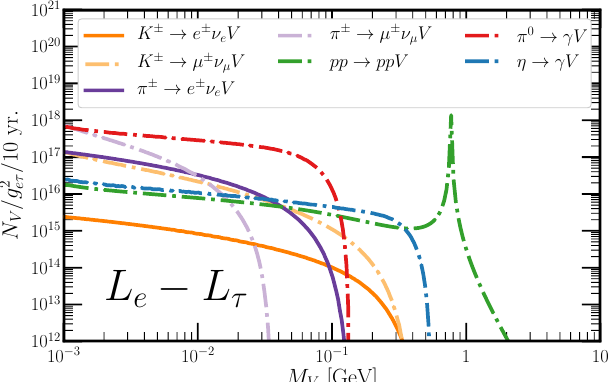
Figure 10 . The number of L e L (cid:28) gauge bosons V traveling towards the DUNE MPD as a (cid:0) function of mass M V assuming ten years of data collection, and equal run time in neutrino and antineutrino modes. Solid lines display expected number due to charged meson decays | purple ( (cid:25) (cid:6) ) and orange ( K (cid:6) ). Dot-dashed lines display expected number due to processes relying on kinetic mixing | red ( (cid:25) 0 decay), blue ( (cid:17) decay), green ( pp ppV bremsstrahlung), purple ( (cid:25) (cid:6) ! decays to muons), and orange ( K (cid:6) decays to